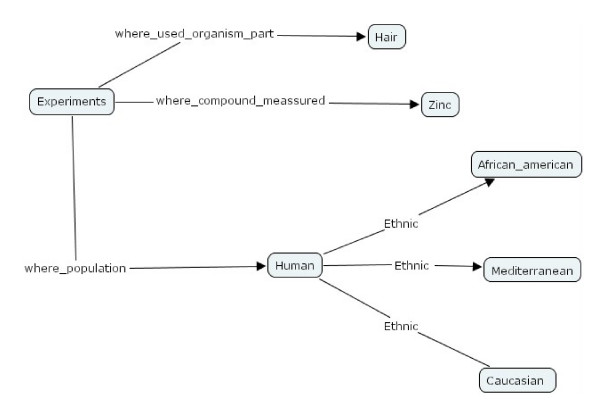
CMs as means to structure a conceptual query.